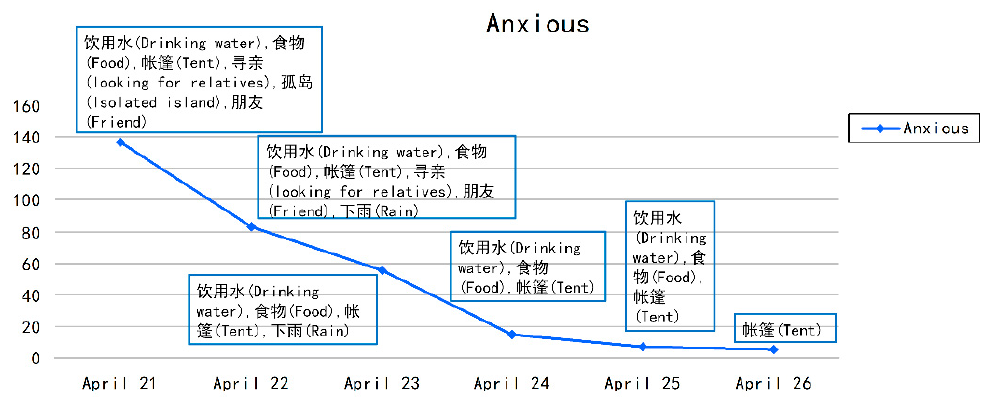
Figure 10. Sequence diagram of anxiety.